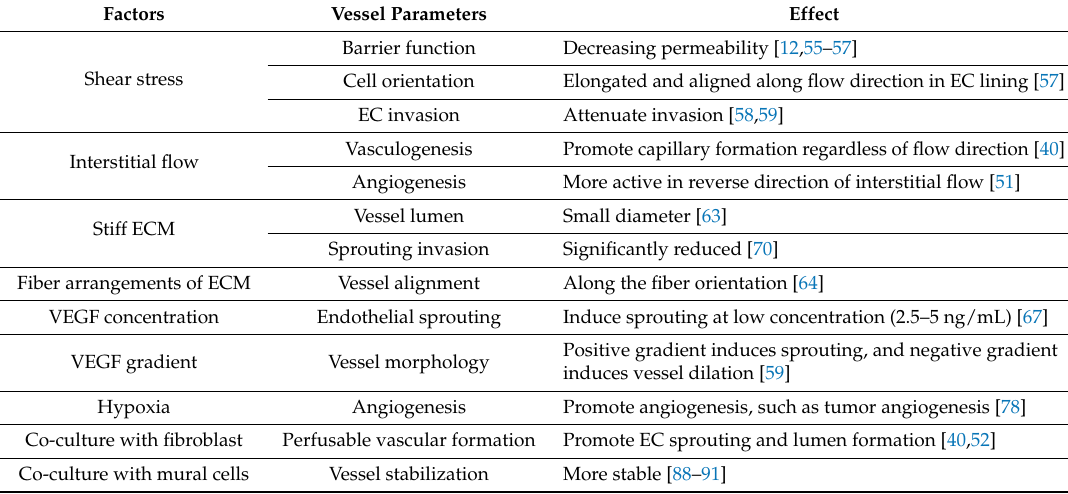
Table 1. Main factors on the influence of different vessel